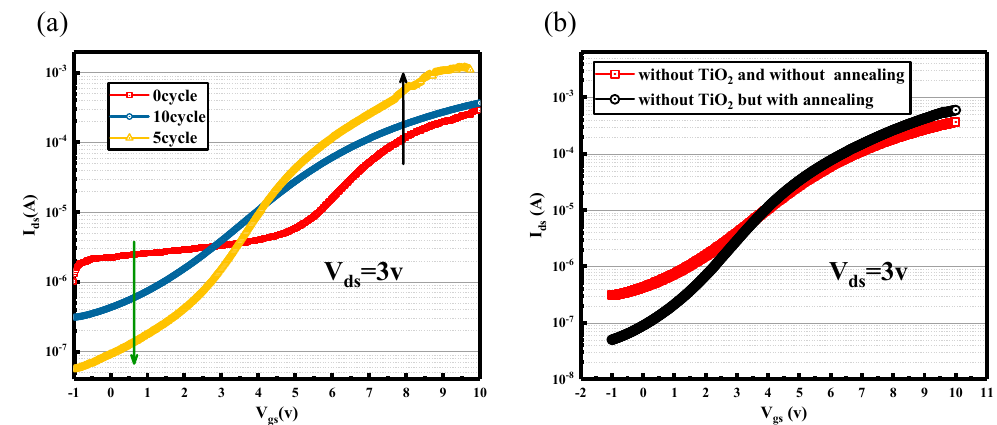
Figure 5. ( a ) Transfer characteristics of TFTs on ITO/PET substrates with different cycles of TiO 2 . ( b ) Transfer characteristics of the annealed TFT which are not deposited TiO 2 on ITO/PET substrates compared with one without annealing.